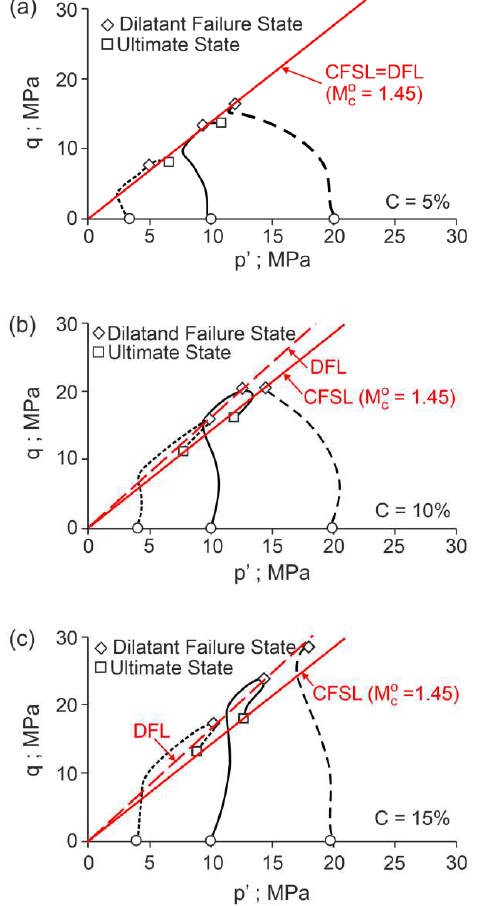
Figure 6. Stress paths for the undrained triaxial compression of cemented Portaway sand: ( a ) 5% cement; ( b ) 10% cement; ( c ) 15% cement (adapted from [10]).